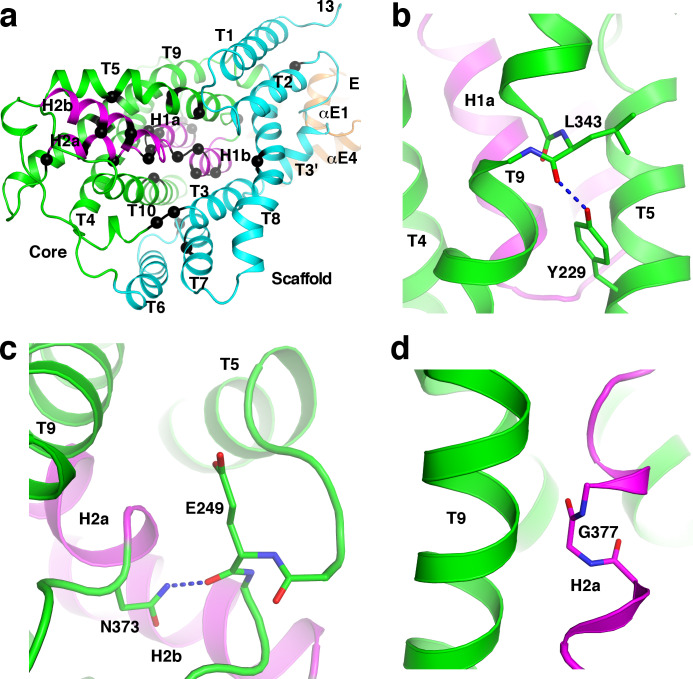
OAD β subunit residues characterized by previous mutagenesis studies.(a) OAD β subunit residues characterized by previous mutagenesis studies on KpOAD. They are mapped onto the structure of the StOAD β subunit and highlighted with black spheres. (b)-(d) Structural basis for the functional importance of Tyr229 (b), Asn373 (c) and Gly377 (d). They contribute to the stability of the core domain by interacting with neighboring residues.